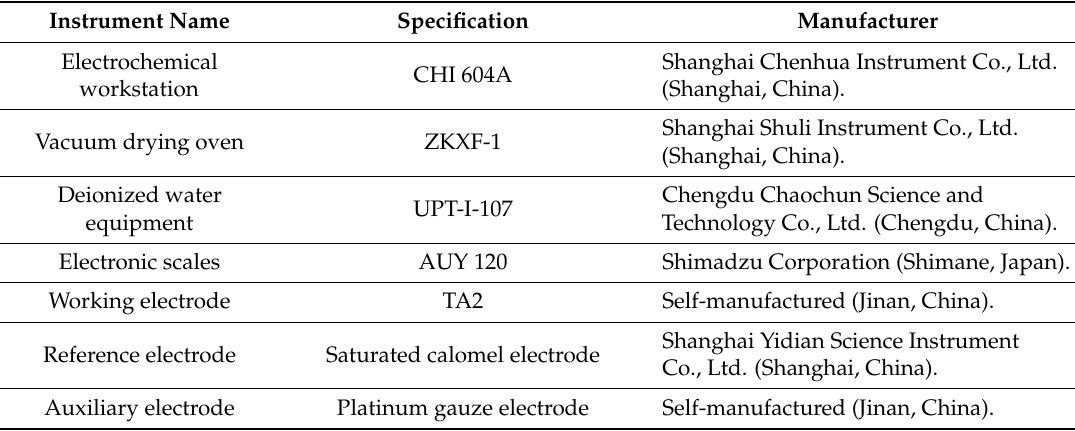
Table 2. Experimental